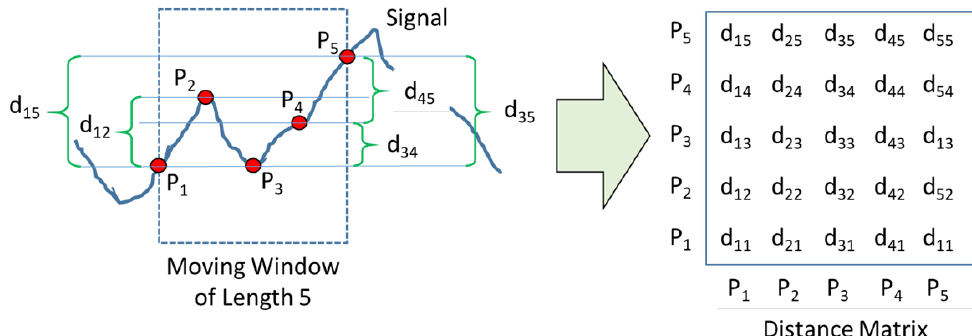
Figure 5. Generation of a distance matrix associated with a window sliding across a univariate process signal.